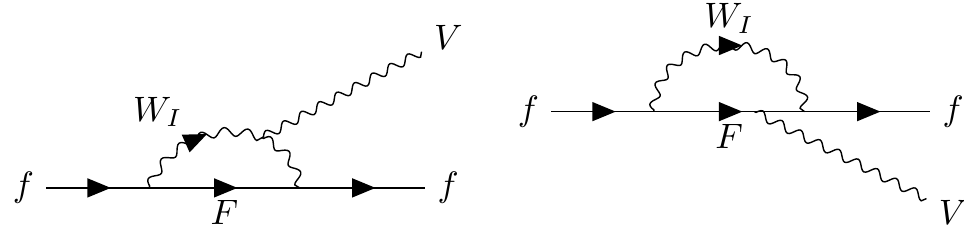
Figure 1 . Typical 1-loop diagrams that can generate the dark magnetic dipole moment interaction in the toy model as discussed in the text. Note there are no graphs with dark photon, V , emission from the external lines as f is a singlet under U(1) D